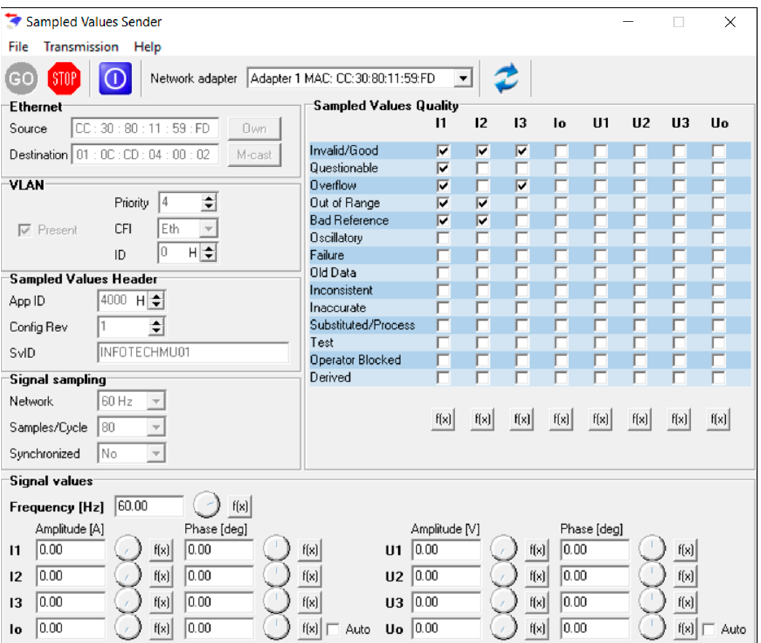
Figure 6. SV message sent from the EV emulator including SoC, P, and Q values.